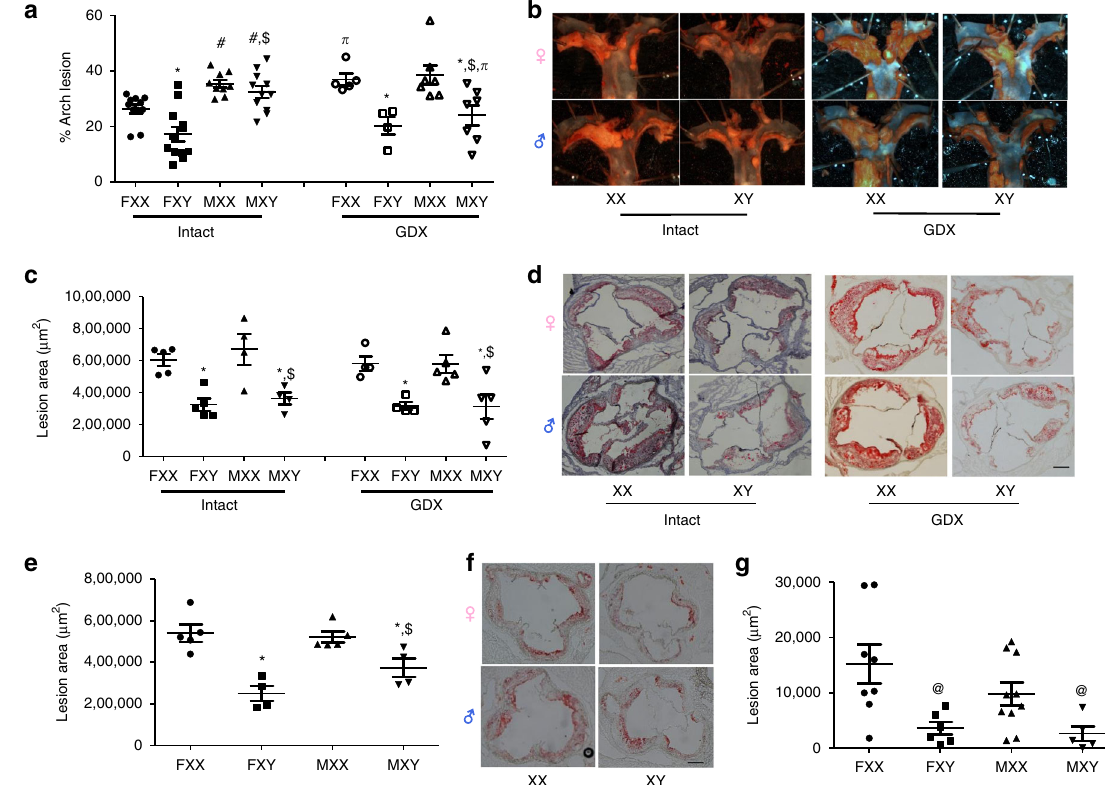
Fig. 3 An XX sex chromosome complement augments atherosclerosis in male and female mice. a Atherosclerotic lesion surface area, expressed as a percentage of the aortic arch, in aortic arches from male and female XX and XY intact or gonadectomized (GDX) Ldlr − / − mice. (Intact: FXX, n = 11; FXY, n = 12; MXX, n = 9; MXY, n = 11; GDX: FXX, n = 5; FXY, n = 4; MXX, n = 7; MXY, n = 7). b Representative aortic arch, stained with Oil Red O, from Ldlr − / − mice of each group. c Atherosclerotic lesion area, quanti fi ed as Oil Red O staining, in tissue sections from the aortic sinus of male and female XX and XY intact or GDX Ldlr − / − mice. (Intact: FXX, n = 4; FXY, n = 5; MXX, n = 4; MXY, n = 4; GDX: FXX, n = 4; FXY, n = 4; MXX, n = 5; MXY, n = 5). d Representative aortic sinus tissue sections, stained with Oil Red O, from Ldlr − / − mice of each group. e Atherosclerotic lesion area in tissue sections from XX and XY male and female Apoe − / − GDX mice. (FXX, n = 5; FXY, n = 4; MXX, n = 5; MXY, n = 4). f Representative aortic sinus tissue sections from Apoe − / − GDX mice of each group. g Atherosclerotic lesion area in tissue sections from aortic sinus of XX and XY male and female C57BL/6 GDX mice fed an atherogenic diet. Symbols represent individual mice per group per measurement, with horizontal lines representing mean ± SEM. (FXX, n = 8; FXY, n = 6; MXX, n = 10; MXY, n = 5). * P < 0.05 compared to XX within gonadal sex. # P < 0.05 compared to female within sex chromosome complement. $ P < 0.05 compared to XX females. Data were analyzed by 3-way ANOVA (A,C) with Holm – Sidak test, or by 2-way ANOVA ( e , g ) with Holm – Sidak test. Scale bar = 200 μ m. Source data are available as a Source Data fi le Table 2 Multiple linear regression of explanatory variables to atherosclerotic lesion area within the aortic sinus of FCG mice Estimate Standard Error t-value P-value